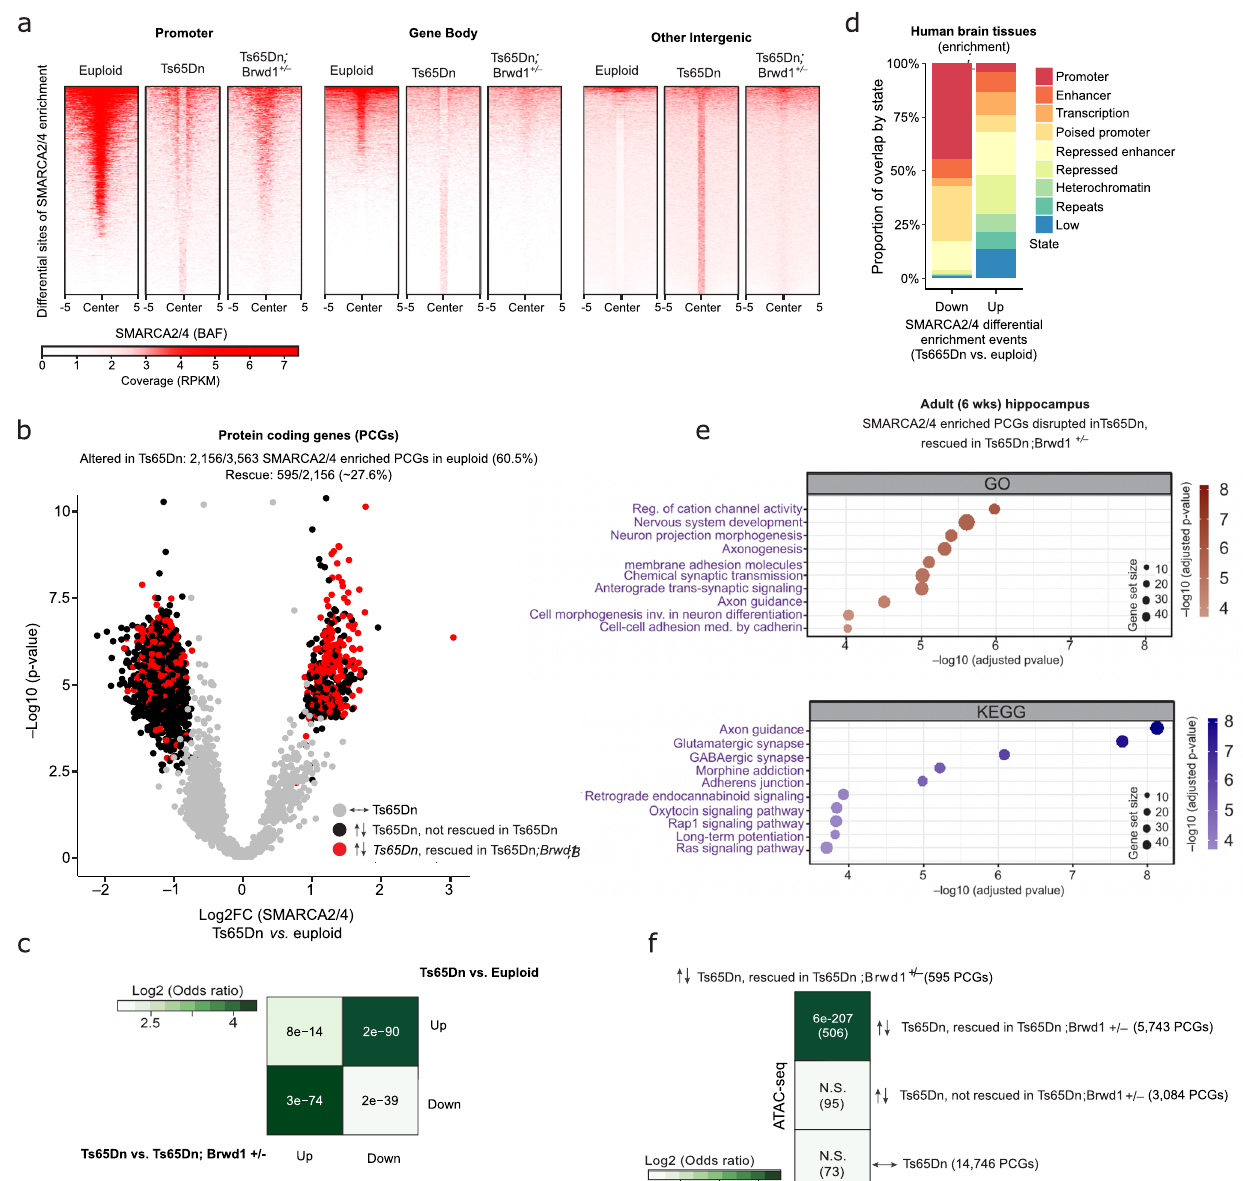
Fig. 4 | Brwd1 renormalization partially rescues genomic BAF complex mis- targeting in male trisomic brain. a Heatmaps of normalized SMARCA2/4 enrichment in euploid vs. Ts65Dn vs. Ts65Dn ;Brwd1 +/ – adult male (6-week) hippo- campus centered (±5kb) over sites of differential SMARCA2/4 enrichment com- paring Ts65Dn vs. euploid mice, separated by genomic context. b Volcano plot depicting regulation of SMARCA2/4 enriched PCGs in euploid animals displaying differential enrichment in Ts65Dn mice; gray circles = unregulated PCGs. Of the PCGsregulatedwithrespecttoSmarca2/4enrichment,595arerescued(redcircles) inTs65Dn ;Brwd1 +/ – mice,whereastheremainderofPCGsdonotdisplaysuchrescue (black circles). c Relative frequency (observed/expected overlap in base pairs) of eachchromatinstatewithinsigni fi cantdifferentiallyenrichedsitesforSMARCA2/4 (Ts65Dn vs. euploid).Chromatin states wereobtained from brain regions included